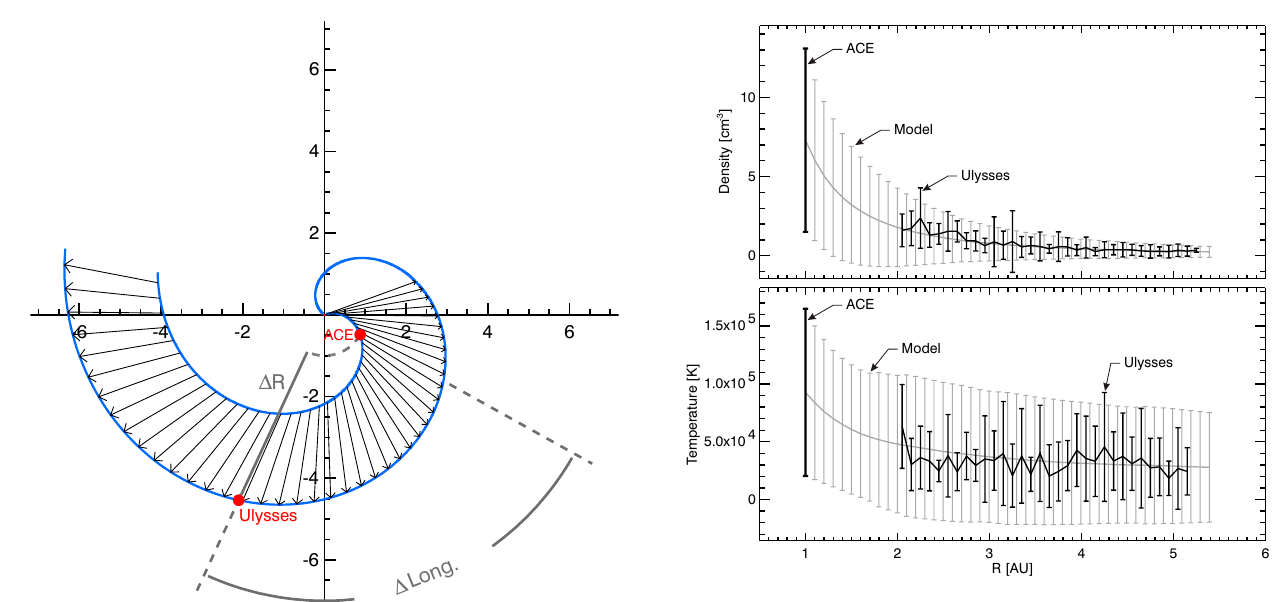
Fig. 2. Diagram of LARP method. Blue lines are magnetic field lines, red dots are spacecraft, and black arrows are velocity vectors. The Sun is at the center and the units of distance areAU.